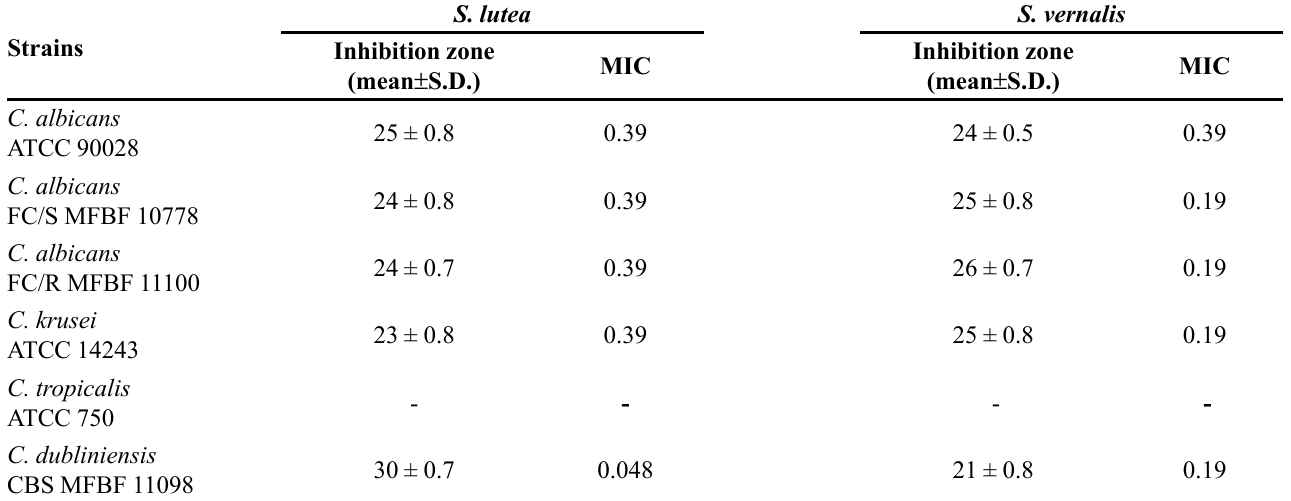
TABLE II - The antimicrobial activities of Sternbergia spp. as diameter of inhibition zone (mm) and MIC value (mg/mL)